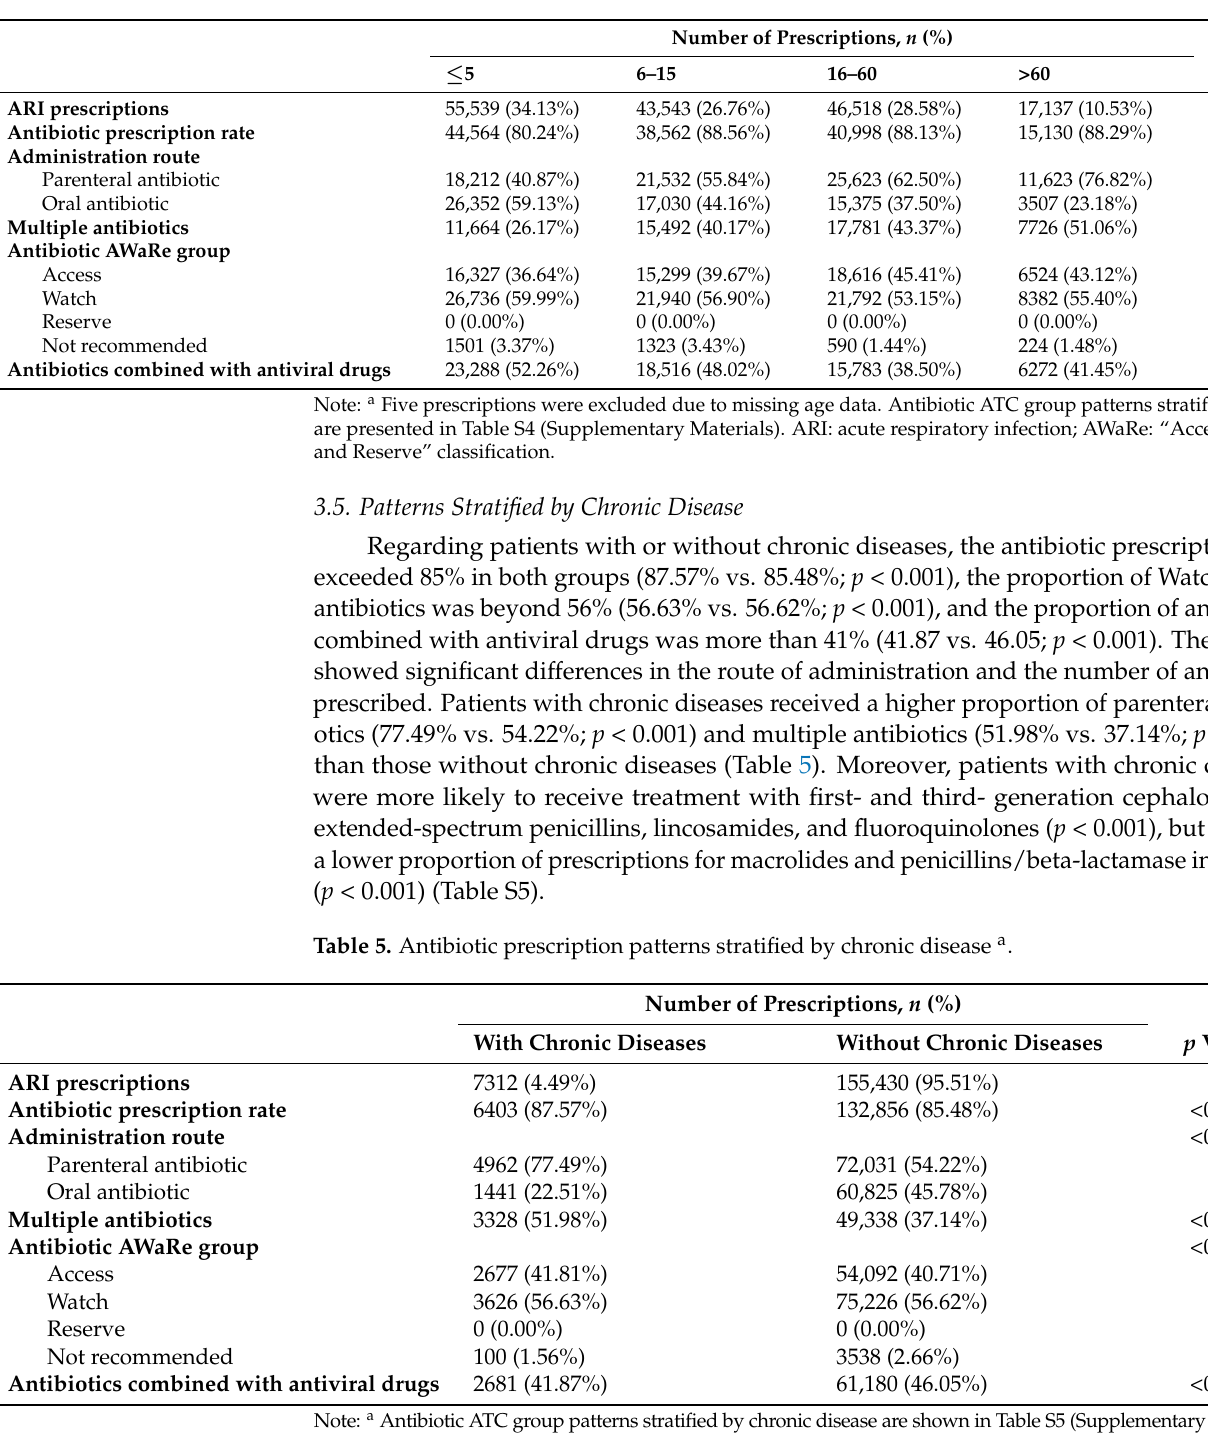
Table 4. Antibiotic prescription patterns stratified by age (in years) a .